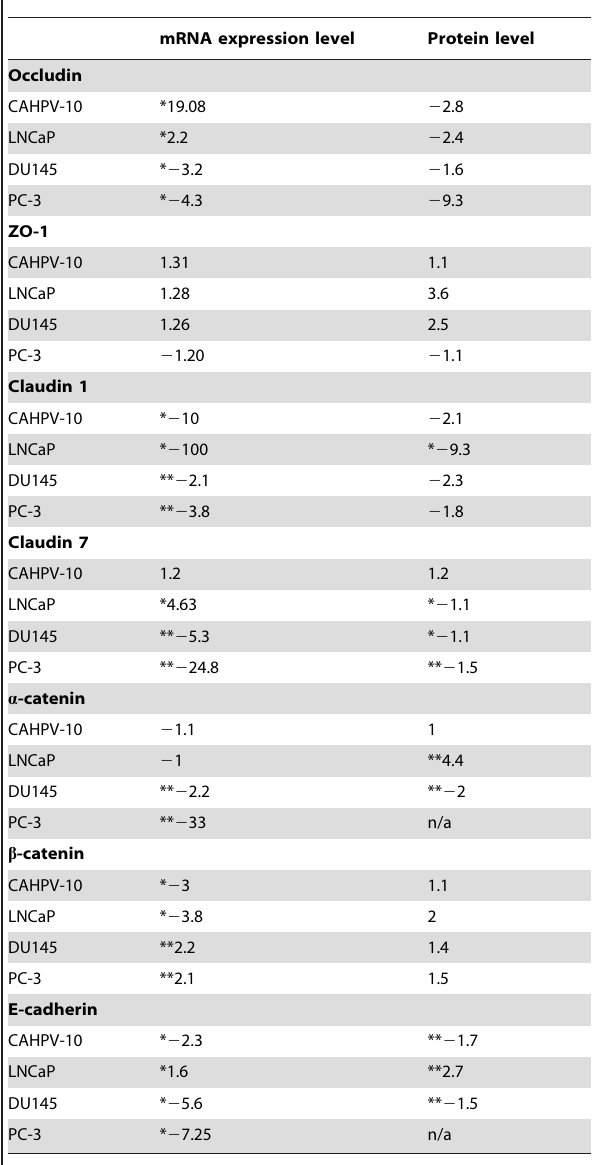
Table 2. mRNA expression and protein level fold changes compared to the normal prostate cells PNT2 for adherens (AJ) and tight junction (TJ) components.